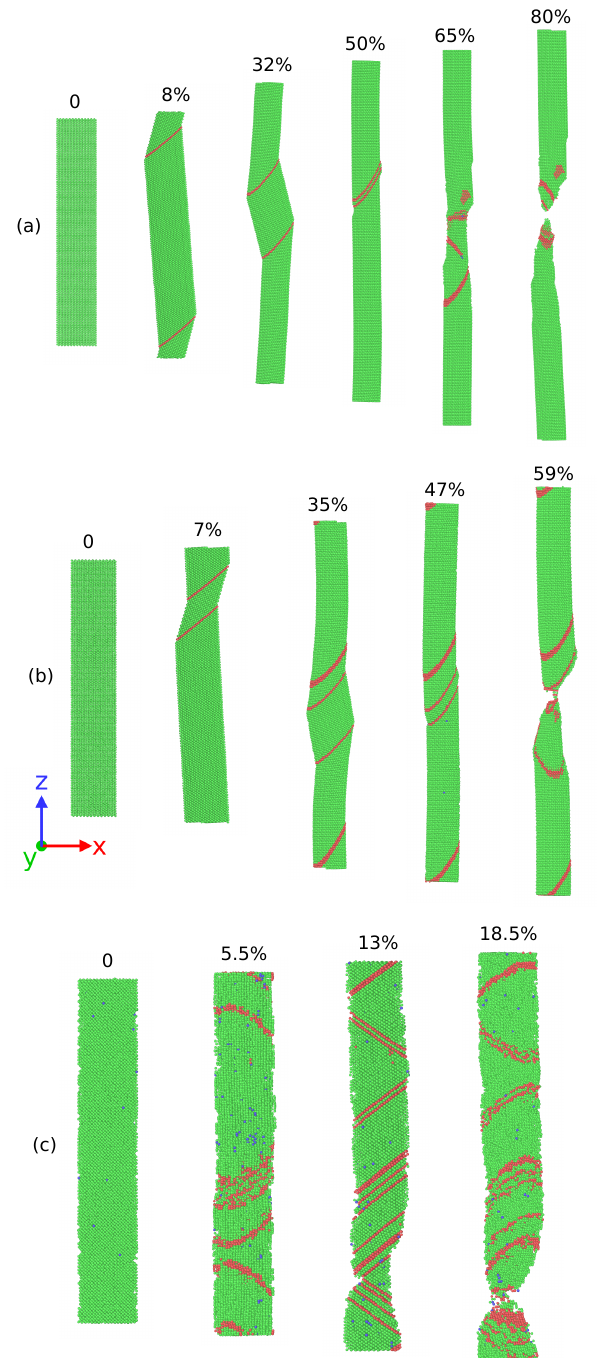
Figure 3. Atomic snapshots showing deformation behavior of single crystal Ag nanowires at ( a ) 77 K; the area between two twin boundaries transforms from (110) to (100) up to 50% strain value. Sub- sequently, single crystal nanowire reoriented along (100) deforms during 50-80% strain. ( b ) 300 K, complete reorientation from (110) to (100) single crystal could not take place. ( c ) 1000 K, no twinning induced reorientation observed. The percentage indicates the value of the applied uniaxial strain in the Z direction. The green and red atoms indicate FCC and HCP atoms